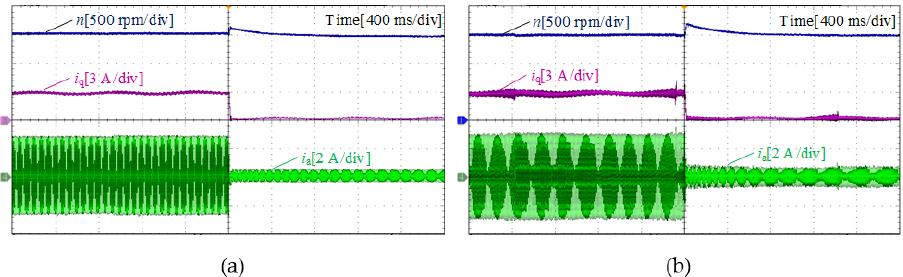
Figure 8. Dynamic experimental waveforms when the load torque suddenly changes from 0.2 Nm to